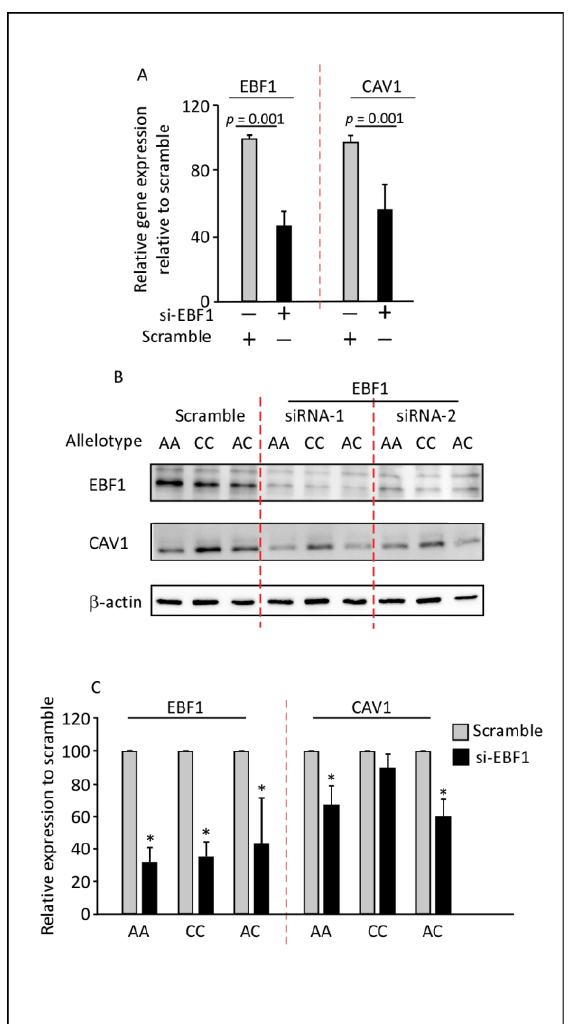
Figure 4. EBF1 siRNA reduces CAV1 expression levels in preadipocytes. ( A ) EBF1 knockdown using siRNA resulted in a significant reduction in CAV1 expression levels. RT-qPCR results were normalized to GAPDH and expressed relative to scramble siRNA controls. Data are presented as mean ± SD; unpaired two-tailed t-test ( n = 3). ( B , C ) Preadipocytes were transiently transfected with scramble siRNA or with EBF1 siRNA. The Western blots were developed with antibodies against EBF1, CAV1, and β -actin, as indicated. EBF1 expression was significantly reduced in all genotypes. CAV1 expression was reduced in the preadipocytes harboring AA and AC genotypes compared to the scrambled control for each genotype. Data are presented as mean ± SD; unpaired two-tailed t-test ( n = 3). CAV1: caveolin-1; EBF1: early B-cell factor 1; AA: CAV1 rs1997623 variant A alleles; CC: CAV1 rs1997623 variant C alleles; AC: CAV1 rs1997623 variant with A and C alleles. * p <